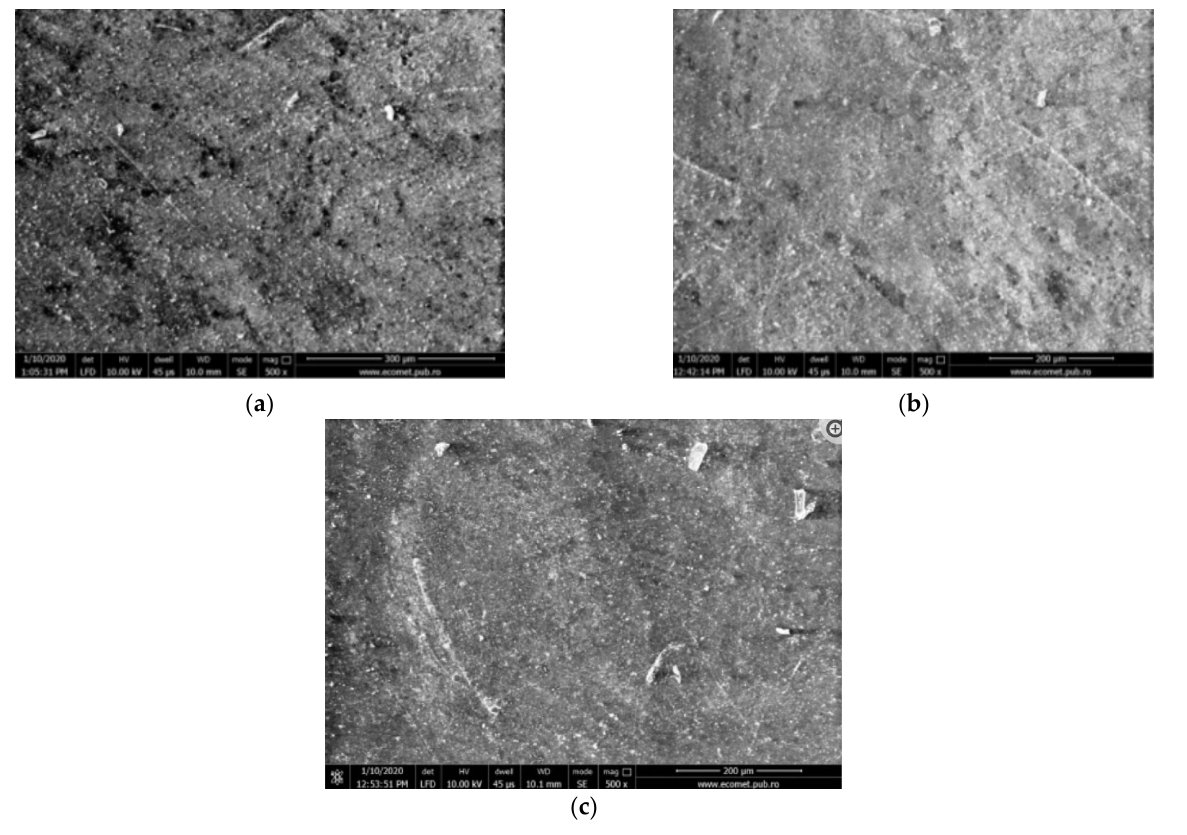
Figure 9. Scanning electron microscope (SEM) images for ( a ) rPP/SBS/GB5 (scale bar 300 µ m); ( b ) rPP/SIS/GB5 (scale bar 200 µ m); ( c ) rPP/SIS/GB20 (scale bar 200 µ m)